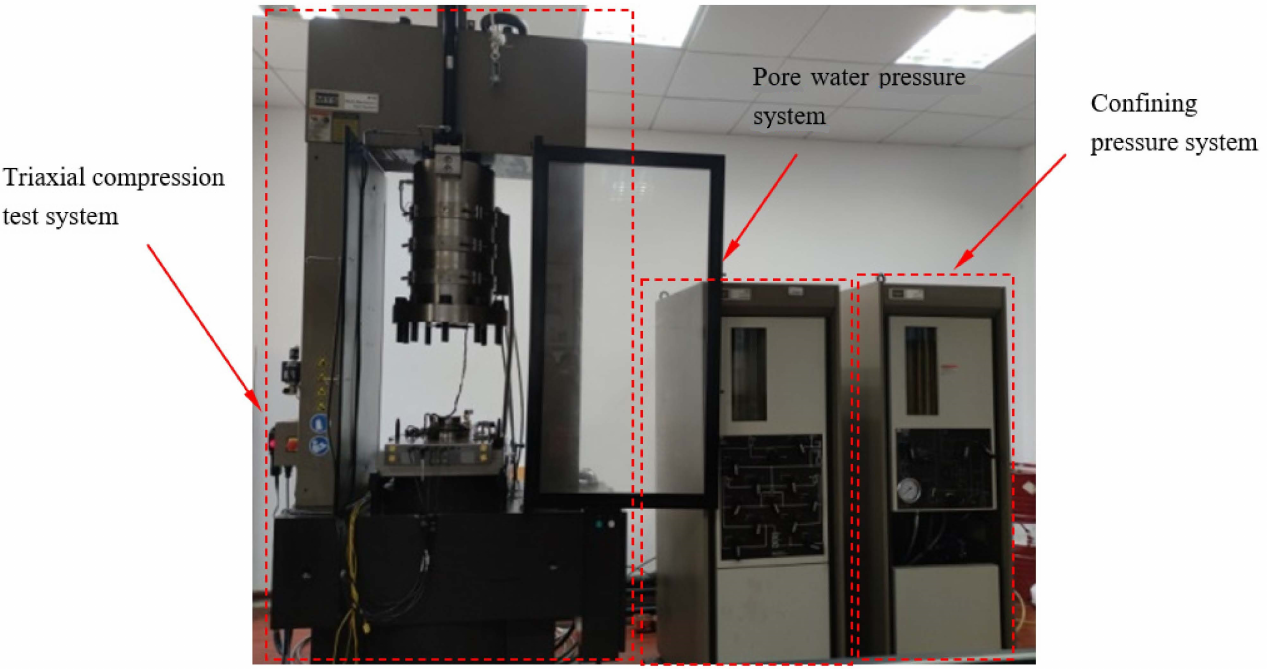
Figure 2. MTS815 rock multi-function electro-hydraulic servo testing